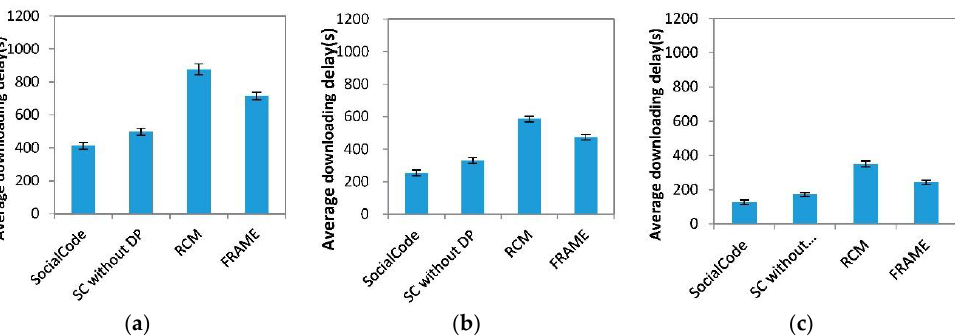
Figure 10. Average downloading delay vs. file size ( a ) 10 MB; ( b ) 6 MB; ( c ) 2 MB.